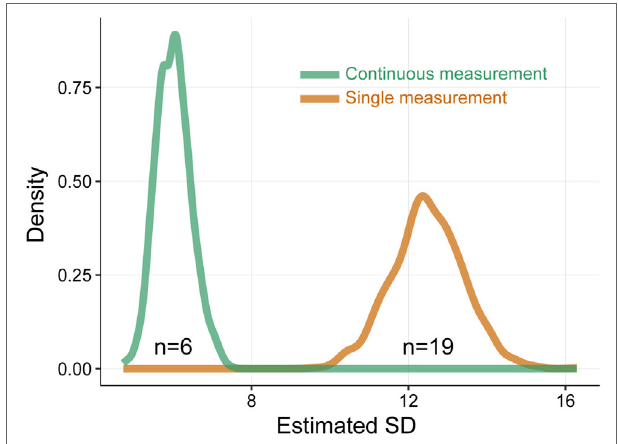
FigUre 4 | Simulation on sample size requirements. Simulation to evaluate the effect of continuous blood glucose measurement on sample size requirements. The simulation is based on 1,000 simulation runs with 100 animals per run. SD of continuous blood glucose measurements and single measurements is computed and aggregated over simulations. The sample size necessary to detect a 10% mean change with 80% power is computed based on average SD. The single measurement-based analysis overestimates the within-sample variability. With a “true” SD of 6, the single measurement-based analysis estimates an SD of 12.5, whereas the continuous blood glucose measurement-based analysis estimates an SD of 6.0. This results in larger sample sizes required to detect a given effect in single measurement-based analysis (19 vs. 6 in continuous blood glucose measurement-based analysis).